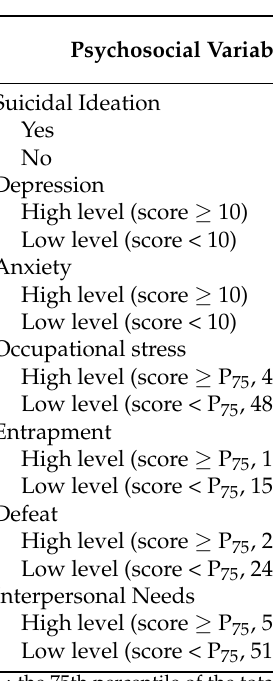
Table 2. The frequency distribution of psychosocial